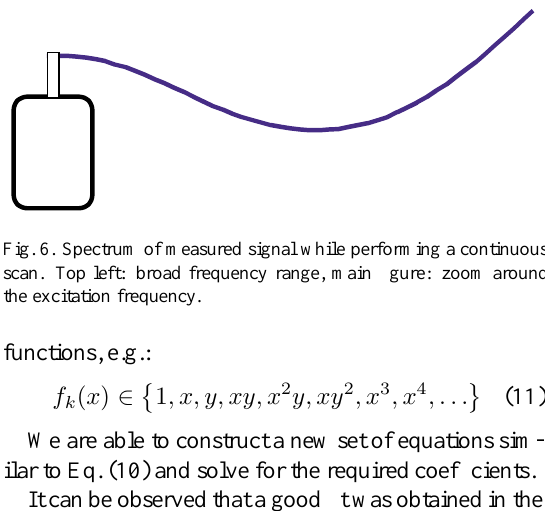
Fig. 5. The measured velocity the sine excitation and sinusoidal scanning.